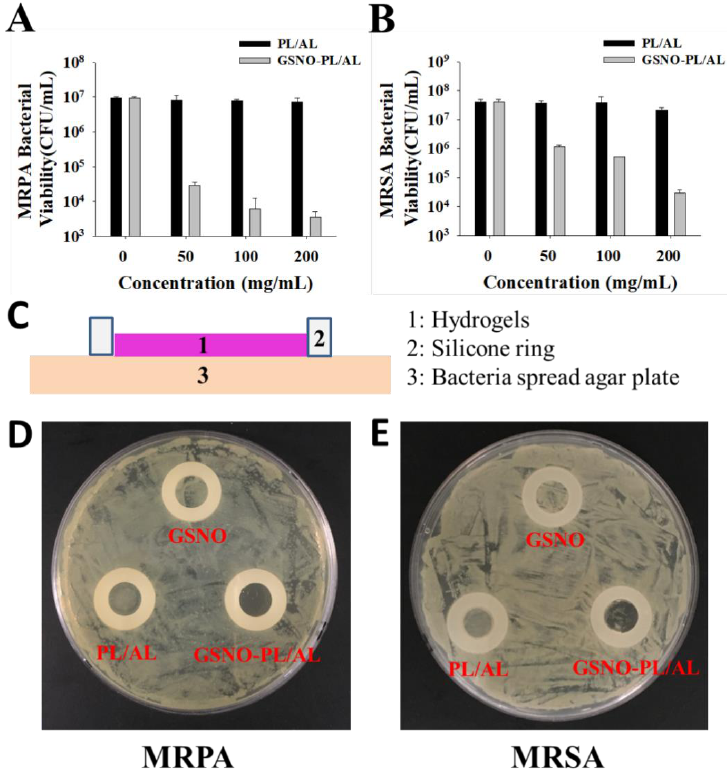
Figure 5. In vitro antibacterial activities of PL/AL and GSNO-PL/AL hydrogels against ( A ) multidrug-resistant Pseudomonas aeruginosa (MRPA) and ( B ) methicillin-resistant Staphylococcus aureus (MRSA). ( C ) Side-view schematic of antimicrobial study configuration using agar plate with bacterial growth. Macroscopic images of antibacterial activities on the agar plate against ( D ) MRPA and ( E )